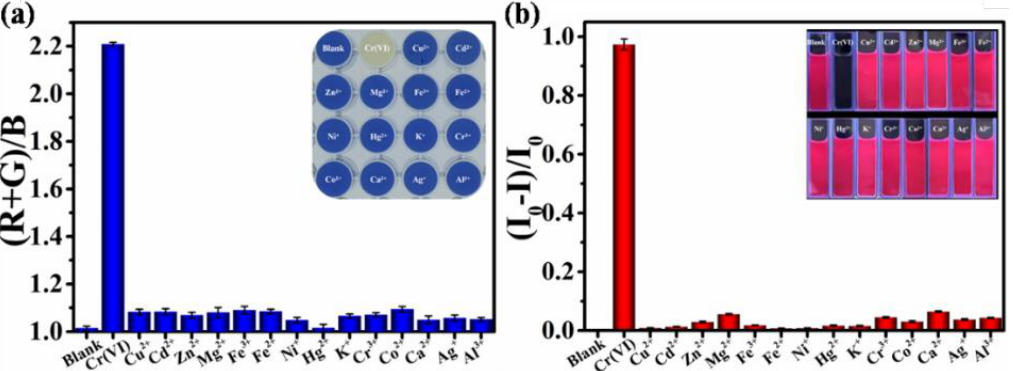
Figure 5. The change of (R + G)/B ( a ) value and the response of fluorescence intensity (I 0 − I)/I 0 ( b ) of R-CDs to different cations. The concentrations of all metal cations are 50 µ M. (Inset: Photographs of corresponding optical and fluorescent specificity to Cr(VI)).